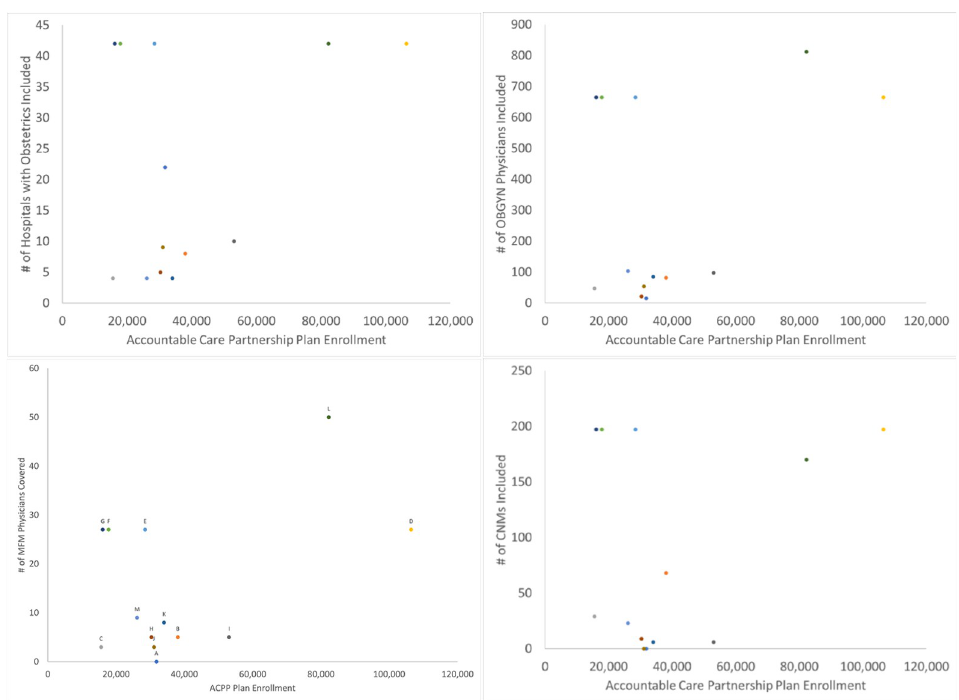
Fig 2. Inclusion of maternity care providers versus ACO enrollment for ACPP ACOs. a. Hospital Inclusion vs. ACPP ACO Enrollment; b. OBGYN Inclusion vs. ACPP ACO Enrollment; c. MFM Inclusion vs. ACPP ACO Enrollment; d. Midwife Inclusion vs ACPP ACO Enrollment. Notes: Each point in the figure represents a single ACPP ACO. ACPP enrollment based on 2018 report by the Center for Health Law and Economics, University of Massachusetts Medical School